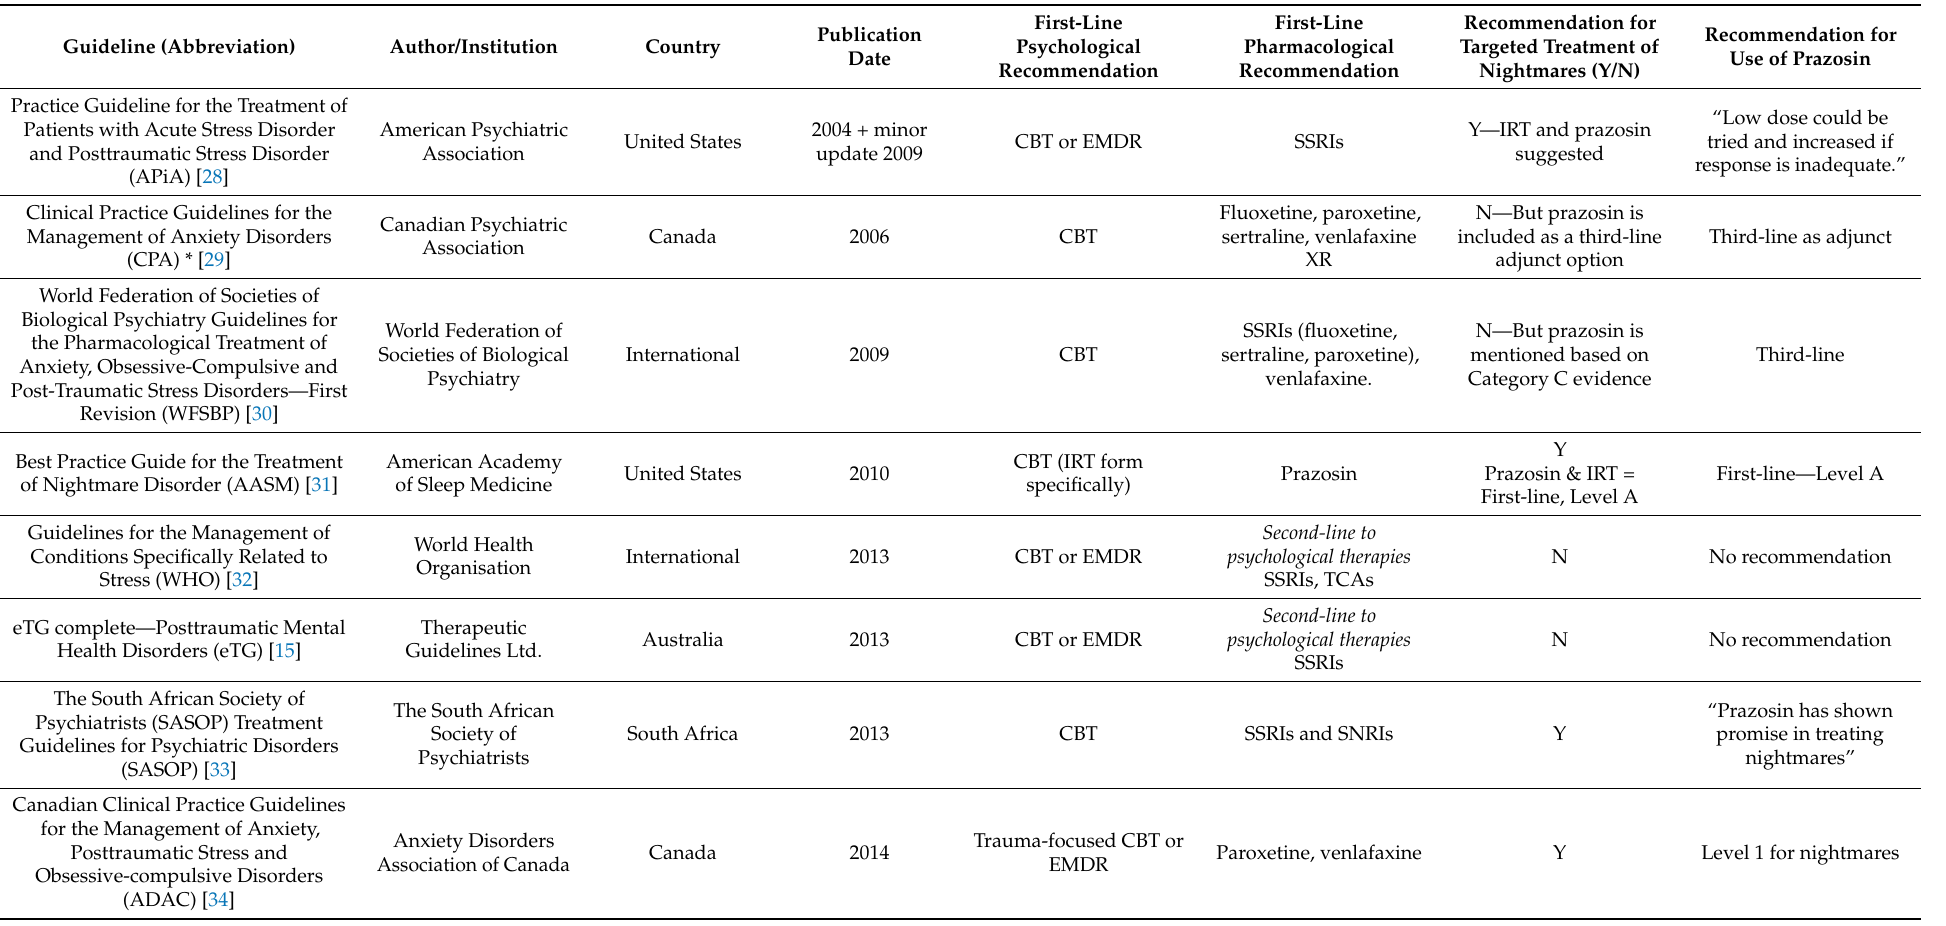
Table 2. Characteristics of included